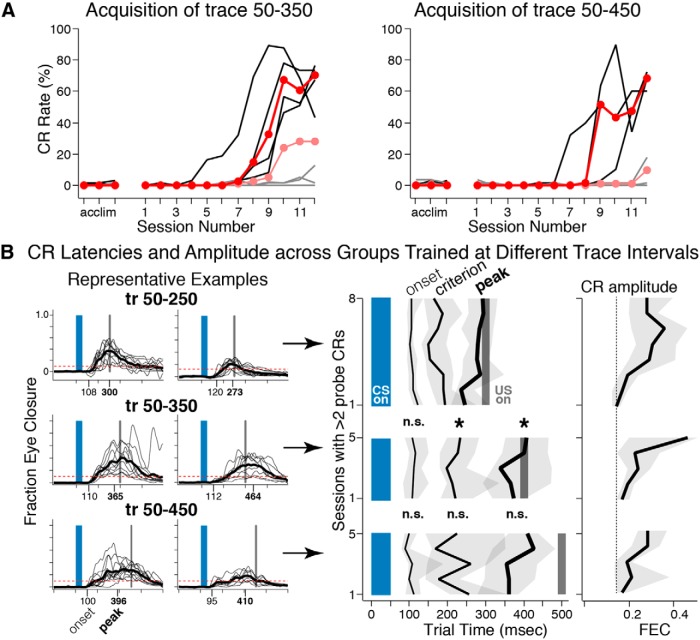
Learning rates and CR latency data for mice trained at trace 50–350 or trace 50–450. A, Only 4 of the 8 mice were able to learn trace 50–350 (left graph), and only 3 of 8 mice were able to learn trace 50–450 (right graph) within 12 training sessions (black lines indicate learners and gray lines indicate nonlearners; red markers show median CR rate for learners and light red markers show the median CR rate for all mice). B, Left graphs show probe trials from two example mice from each of the three groups trained at different trace intervals. Numbers on x-axes give the median latency to CR onset and peak for each example mouse. Note that the latencies to onset are similar across these examples, while the latencies to peak shift with the longer training intervals. Right graph shows group data for CR latencies and amplitude for the 3 training groups beginning with initial expression until the last training session (black lines show median latencies, shaded gray region indicates interquartile range). Mice showed CR onsets that did not vary across the different trace intervals on the final training days (trace 50–250 vs 50–350, Wilcoxon rank: U = 26, n = 4 and 12, p = 0.42; trace 50–350 vs 50–450, U = 5, n = 3 and 4, p = 0.69). Latencies to CR criterion and peak were different between trace 50–250 and 50–350 (Wilcoxon rank: U = 45, n = 4 and 12, p < 0.001 and U = 44, p < 0.001, respectively), with the peaks of CRs appropriately timed for the training intervals used. Mice trained to trace 50–450 showed early latencies relative to the training interval, and were not different from mice trained to 50–350 for any parameter (Wilcoxon rank, Onset: U = 5, n = 3 and 4, p = 0.69; Criterion: U = 8, p = 0.31; Peak: U = 6, p = 0.57). CR amplitudes were similar between the three training groups (rightmost graph, black lines show median for each training day, gray shaded area shows interquartile range, dotted line indicates median amplitude of trace 50–250 mice on the first day of expression as reference).